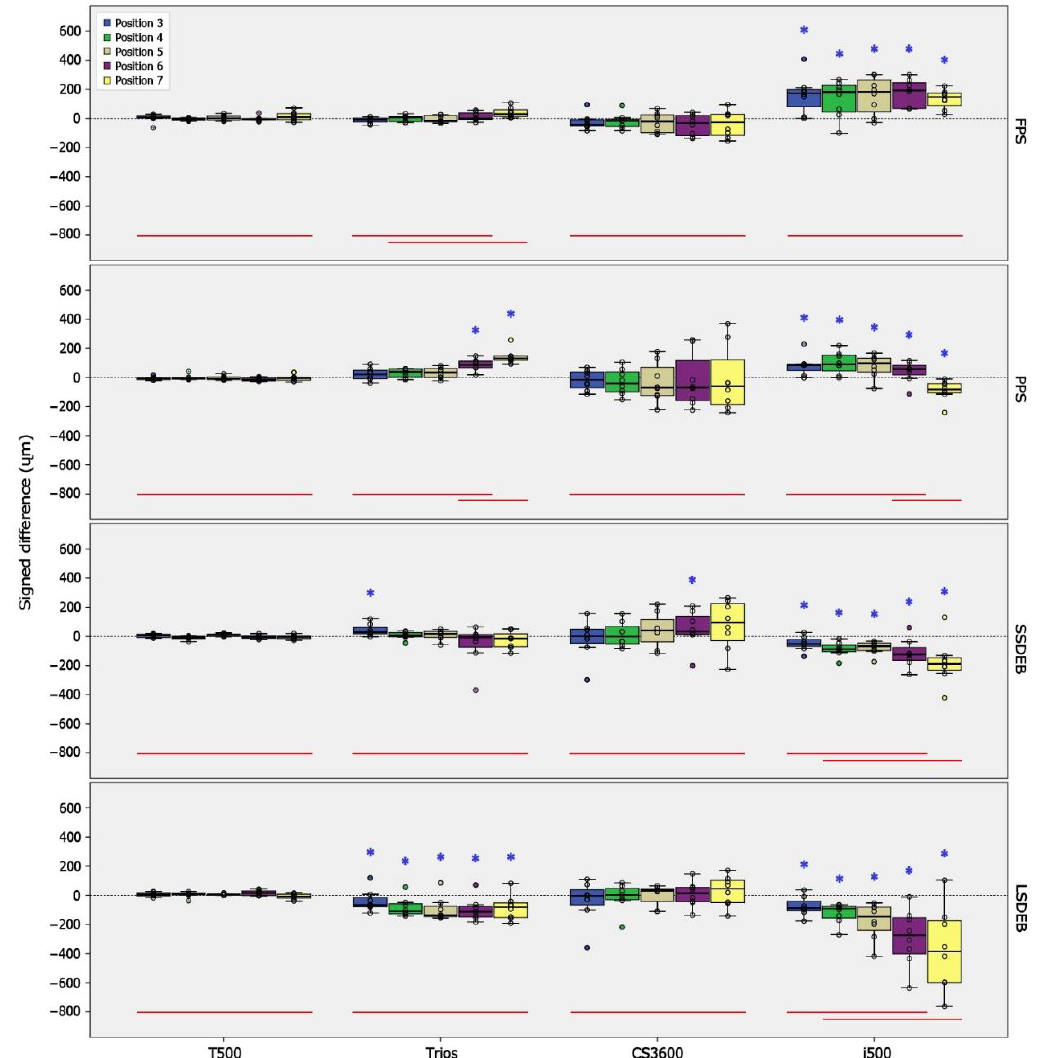
Figure 7. Box plot demonstrating the signed difference of experimental models (Right Y -axis) by various scanners ( X -axis). RMS: Root Mean Square, FPS: Full Posterior Support, PPS: Partial Posterior Support, SSDEB: Short Span Distal Extension Base, LSDEB: Long Span Distal Extension Base. Asterisks indicate a statistically significant difference in the intergroup comparison on the same interarch marker position between the laboratory scanner and IOS ( p < 0.05). The solid line demonstrates no significant difference in the intragroup comparison of signed differences by post hoc analysis. Table 3. The unsigned difference of experimental models (FPS, PPS, SSDEB, LSDEB) by the various scanner (T500, Trios,